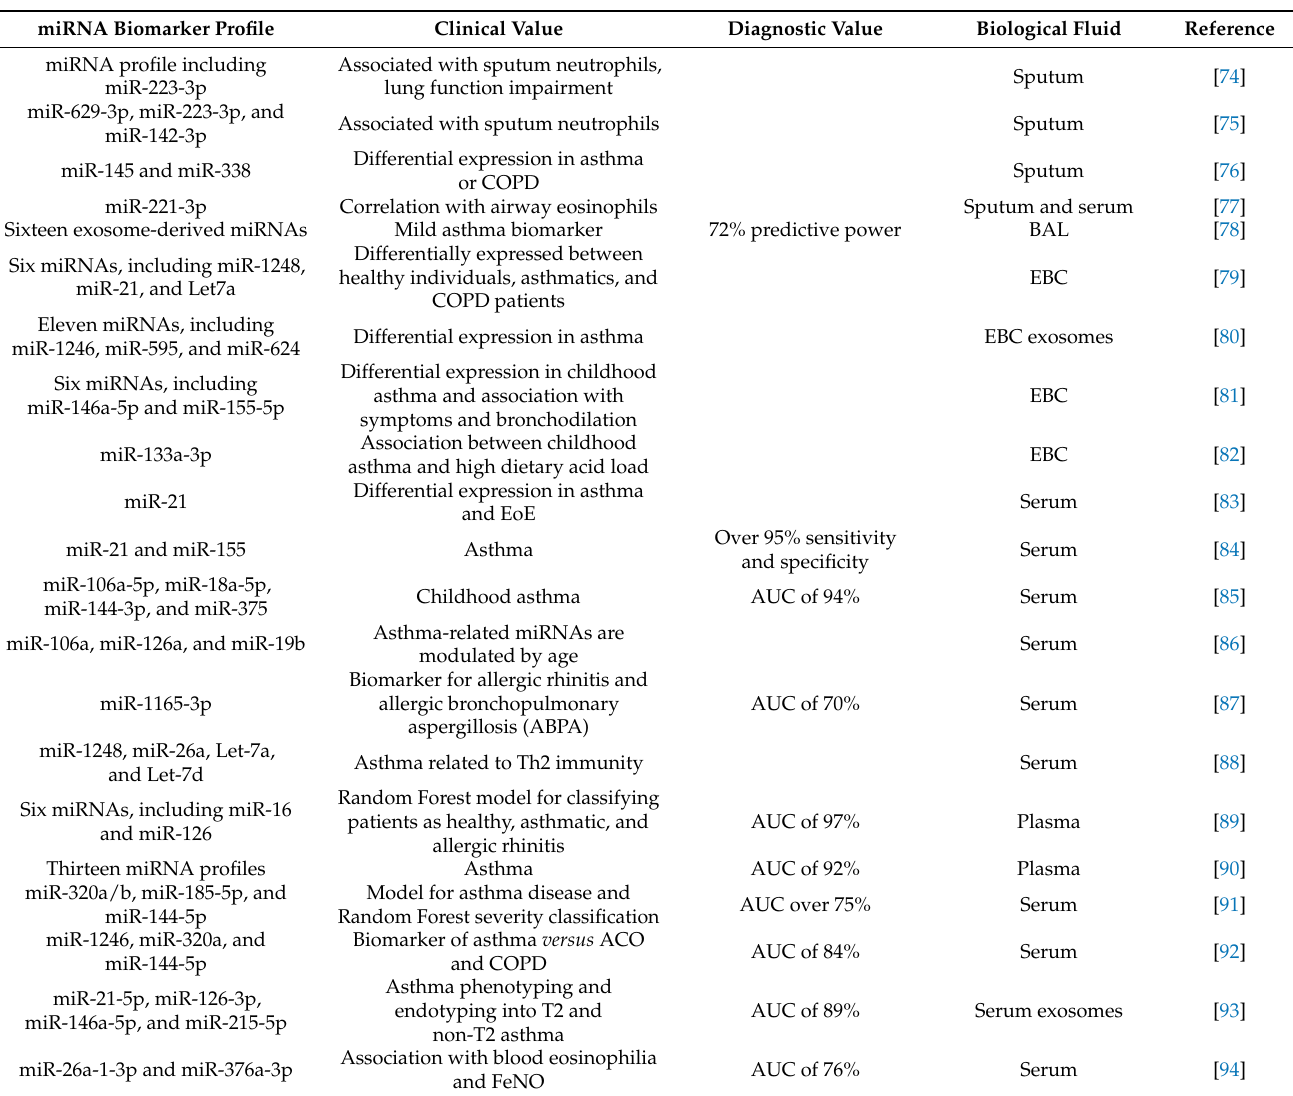
Table 1. miRNA biomarkers of asthma disease and its phenotypes and/or